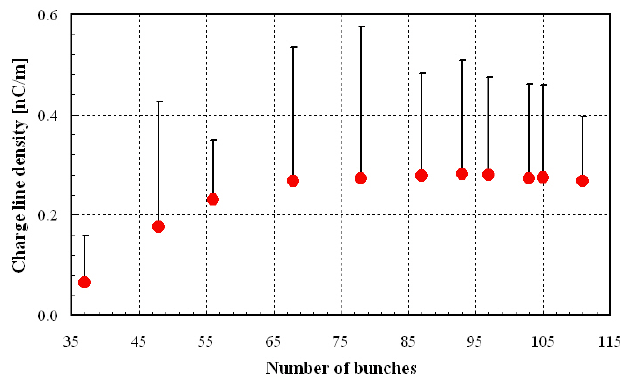
FIG. 22. (Color) Photograph and cross-sectional view of one of the antigrazing rings. In the photograph one of 5 set screws is visible. The tapering of the rings edges is introduced to further reduce their already small impact on the ring impedance